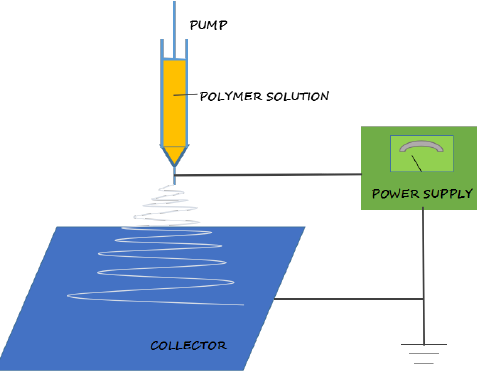
Figure 1. Schematic diagram of an electrospinning set-up.